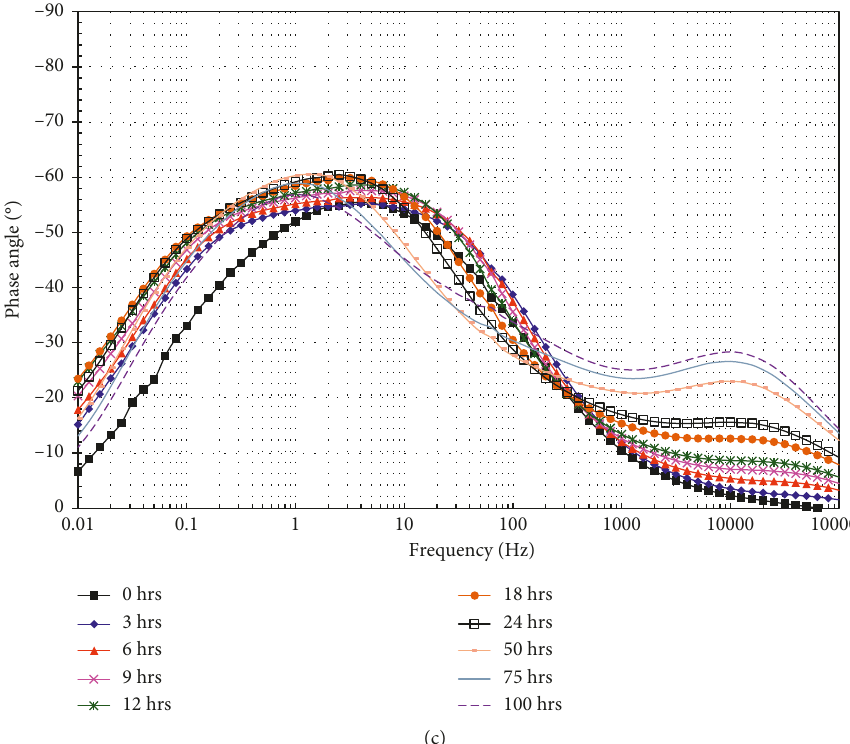
Figure 7: Evolution of the Nyquist and Bode diagrams for API X70 steel in 3.5% NaCl solution with the addition of 0.001M Nd 3+